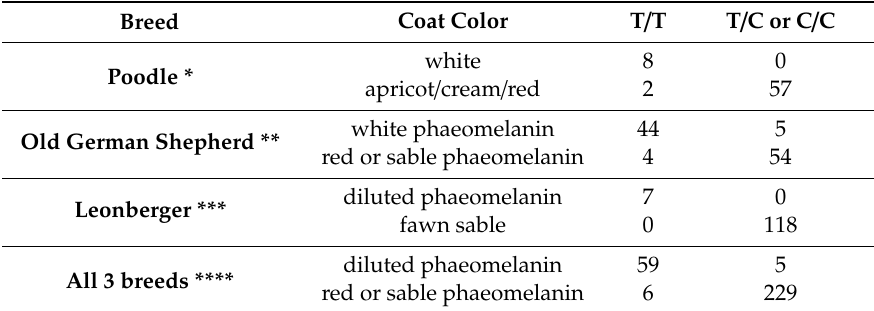
Table 1. Genotyping of MFSD12 variant in Poodle, Old German Shepherd and Leonberger breeds showing enrichment of the variant in dogs with phaeomelanin dilution. Breed Coat Color T / T T / C or C / C white 8 0 Poodle * apricot / cream / red 2 57 white phaeomelanin 44 5 Old German Shepherd ** 4 54 7 0